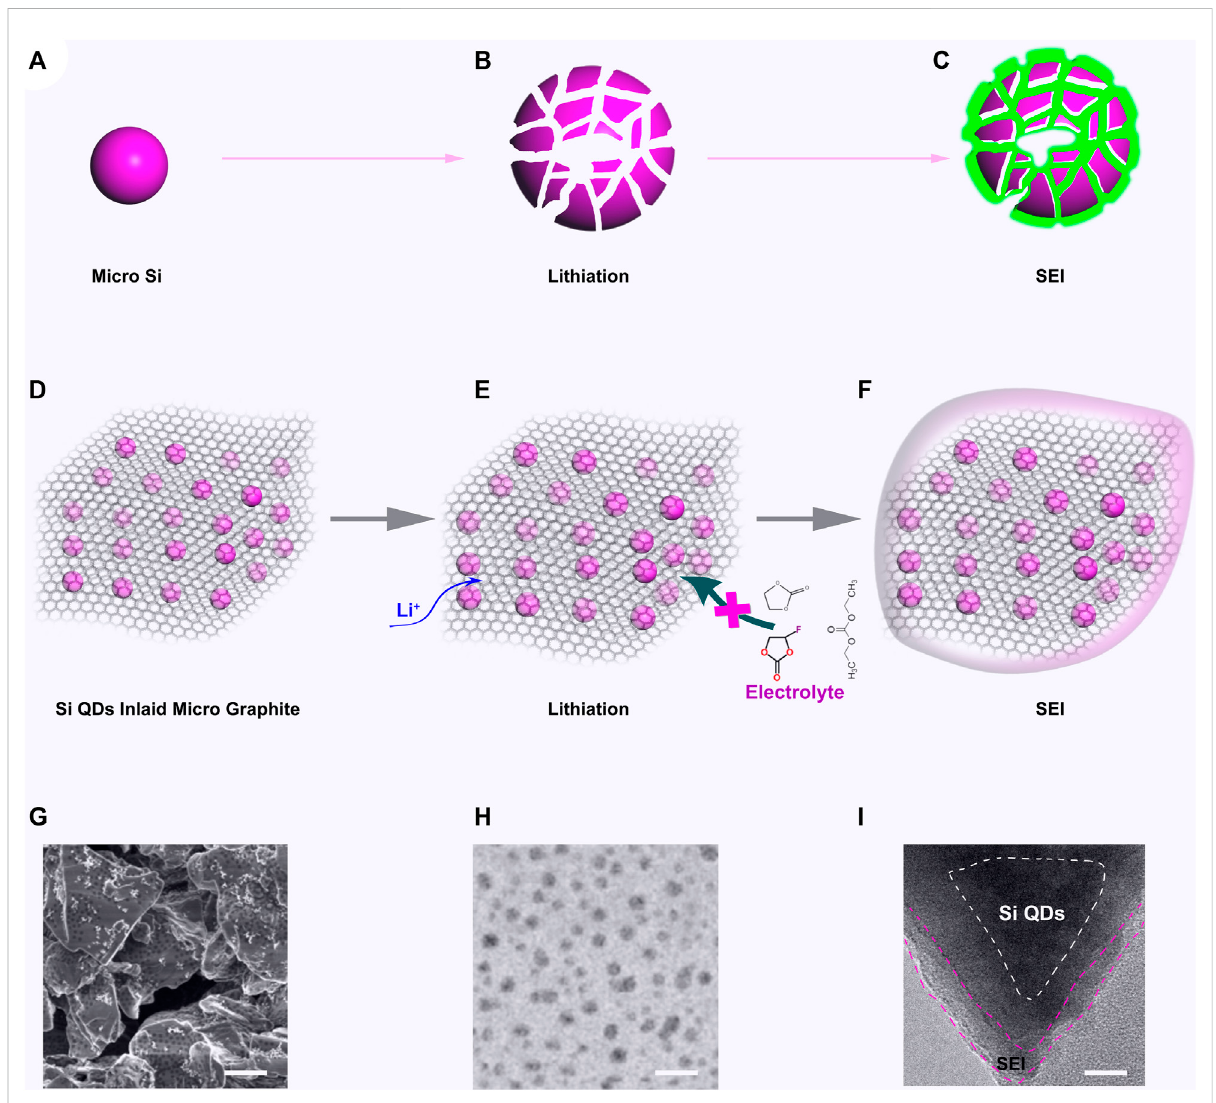
FIGURE 2 (A) The micron Si; (B) Micron Si after lithiation; (C) SEI formation on lithiated Si; (D) SiQDs-in-MG; (E) SiQDs-in-MG after lithiation; (F) SEI formation on SiQDs-in-MG; (G) SEM image of SiQDs-in-MG, scale bar 5 μ m; (H) TEM image of SiQDs-in-MG, scale bar 10nm; (I) TEM image of SiQDs-in-MG after SEI formation, scale bar 2 μ